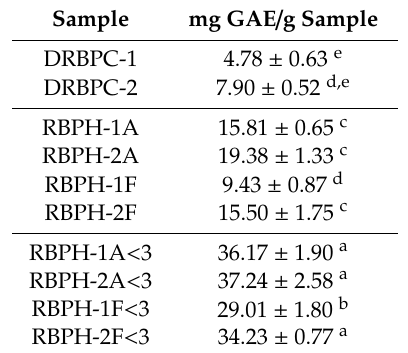
Table 2. Total phenolic compounds (mg gallic acid equivalents (GAE) / g sample) of defatted rice bran protein concentrates (DRBPC-1 and DRBPC-2), protein hydrolysates with alcalase (RBPH-1A and RBPH-2A) and flavorzyme (RBPH-1F and RBPH-2F), and fractions with molecular mass smaller than 3 kDa (RBPH-1A < 3, RBPH-2A < 3, RBPH-1F < 3, and RBPH-2F < 3). Values are given as the means ± standard deviation of three measurements. The same letters indicate no statistical di ff erences ( p > 0.05). Significance was estimated using one-way ANOVA.